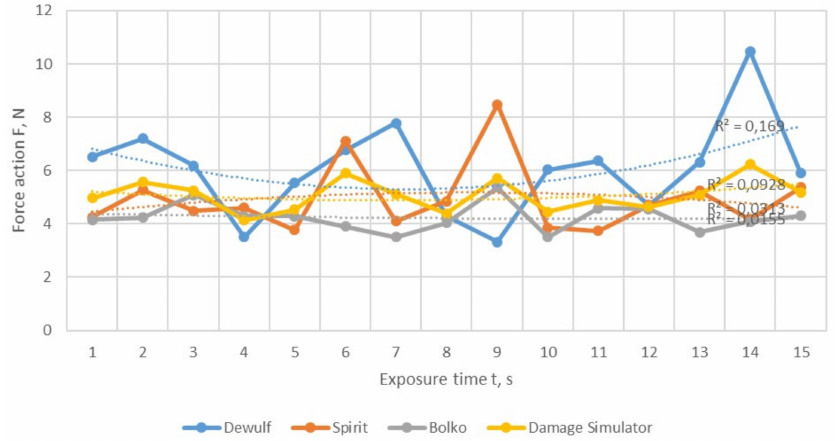
Figure 16. Comparison of force action of separating surfaces on a potato tuber within the test device for evaluation of suitability of potato varieties and hybrids for mechanized